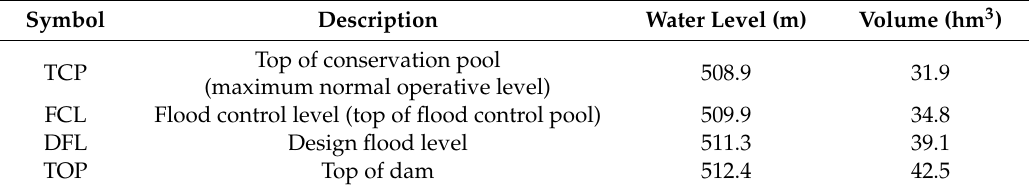
Table 1. Talave Dam characteristics. Levels and storage capacity.